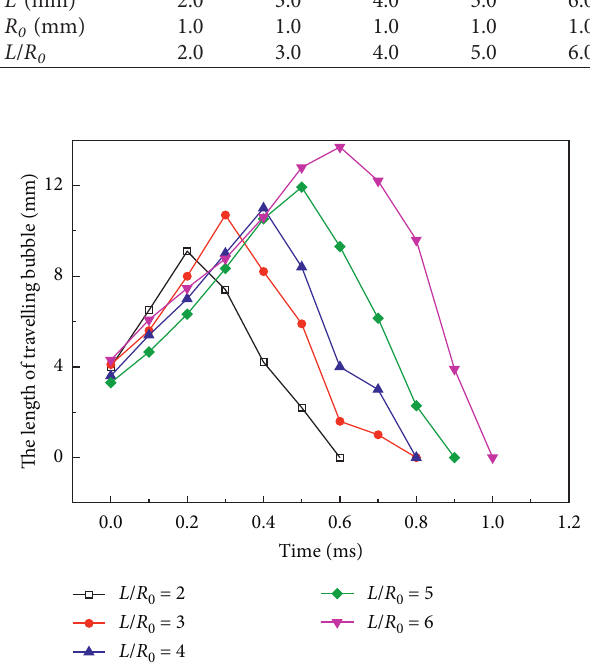
Figure 5: The variable in length of travelling cavitation bubble with different length/diameter